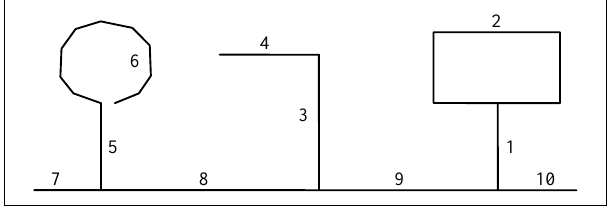
Figure 3. Pattern paths connected by function